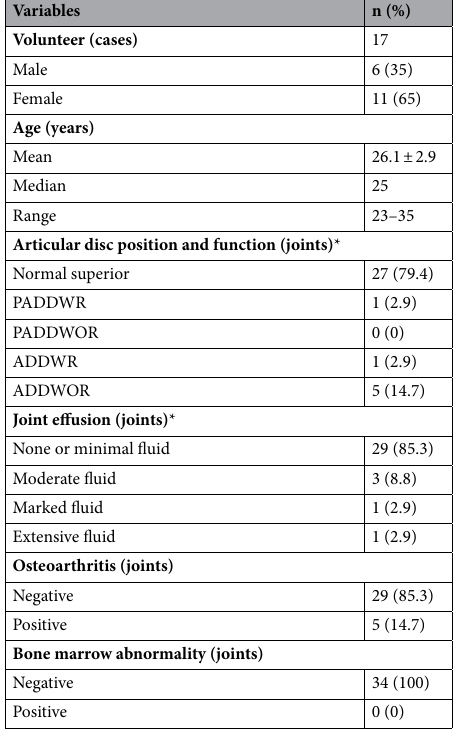
Table 1. Volunteer characteristics and qualitative MRI findings. *Percentages may not total 100 because of rounding. PADDWR, partial anterior disc displacement with reduction; PADDWOR, partial anterior disc displacement without reduction; ADDWR, anterior disc displacement with reduction; ADDWOR, anterior disc displacement without reduction.